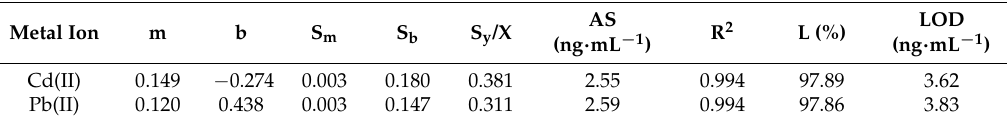
AS: Analytical Sensitivity, L: Linearity. LOD: Limit of Detection, m: Sensitivity ( µ A/ng · mL − 1